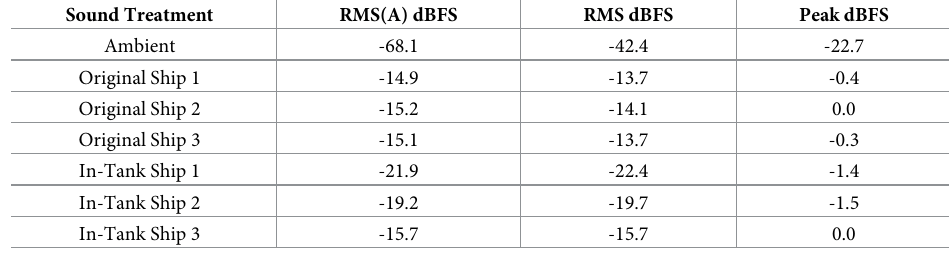
Table 1. Average sound levels for ambient noise, original recording and in-tank recordings. RMS = root mean squared; A = A-weighted; FS = relative to a full scale where the maximum decibel level is 0.0; Peak = maximum decibel level recorded